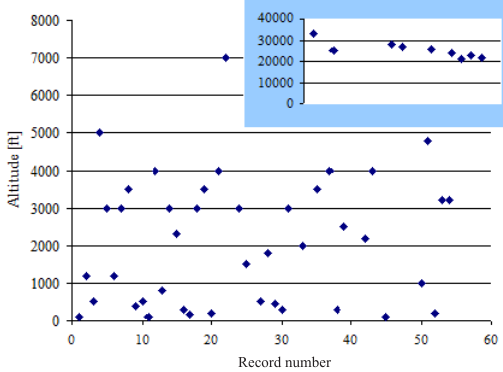
Record Figure 3. Records distribution based on encounter altitude